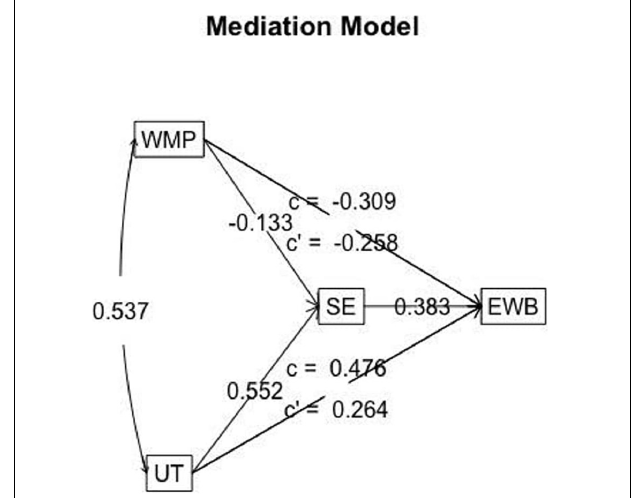
FIGURE 3 | Mediation model predicting emotional well-being.